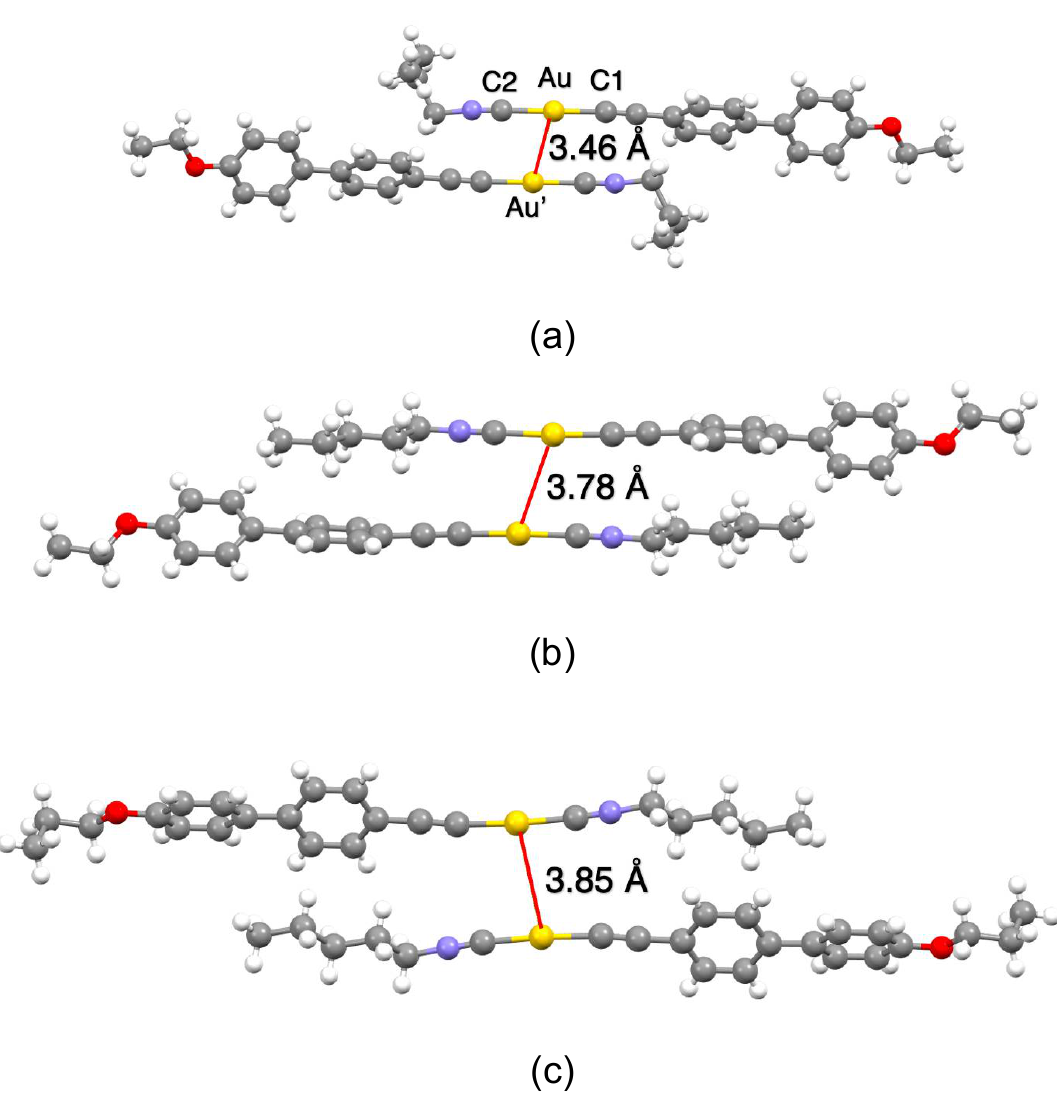
Figure 1. Crystal packing structure of ( a ) B2-4, ( b ) B2-5, and ( c ) B3-5 at room temperature. Red lines represent the Au–Au distances. Atom color legends: gray, C; blue, N; red, O; yellow, Au; white, H.